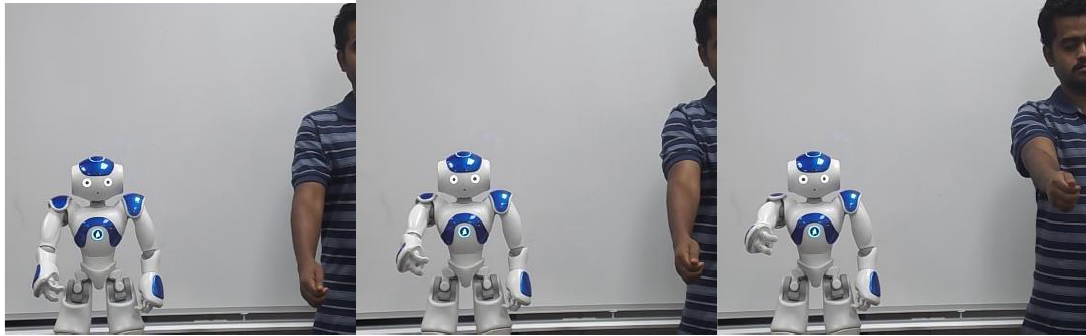
Figure 11: Arm position of human operator and NAO robot during shoulder joint vertical flexion/extension